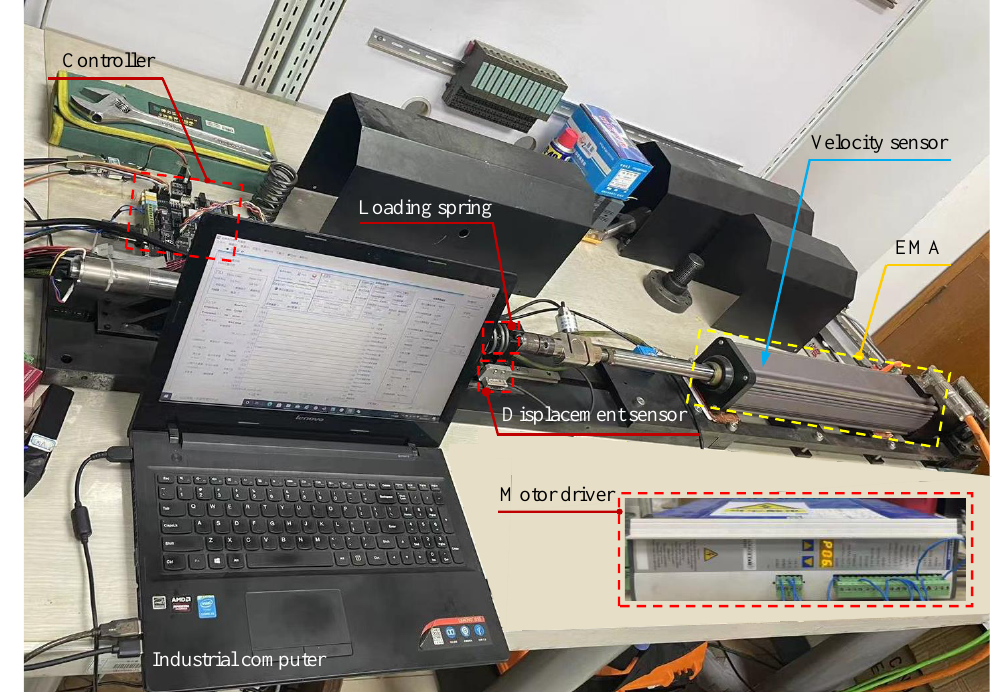
Figure 16. The test rig.